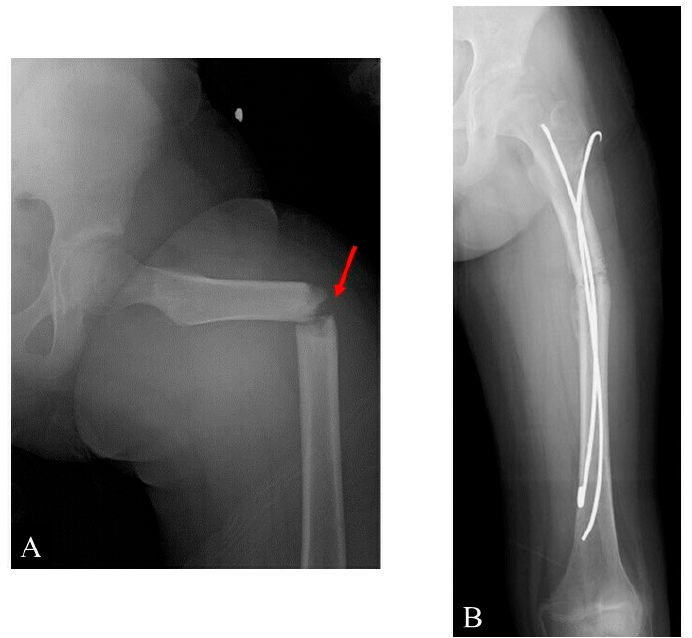
Figure 5. Radiographs: ( A ) a fracture after the O-arm-guided en bloc resection and artificial bone graft and ( B ) post-intramedullary k-wire fixation. Callus formation can be seen.